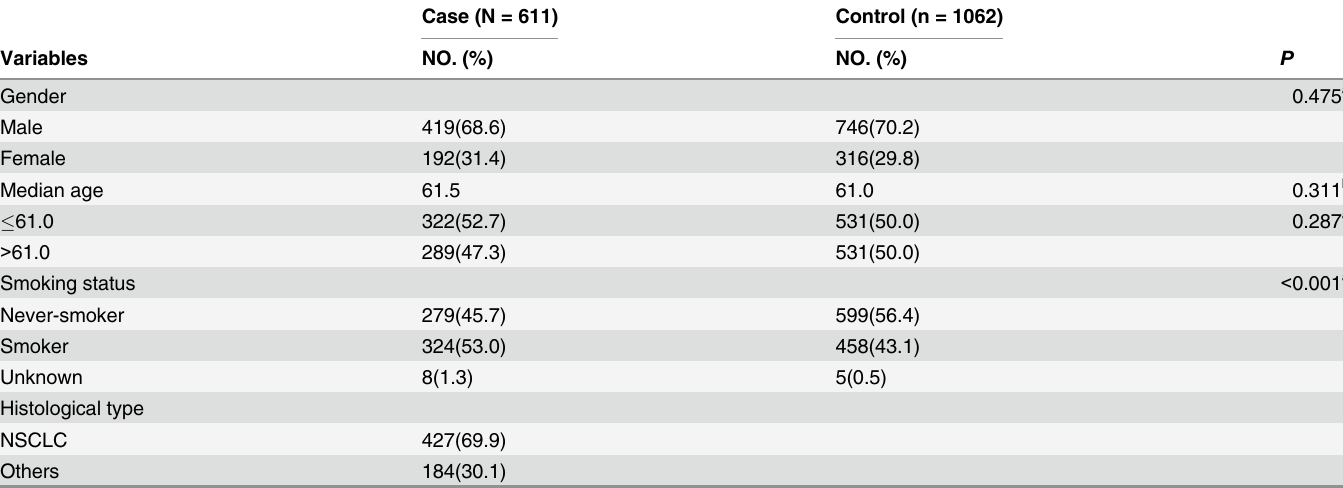
Table 1. The characteristics of the study